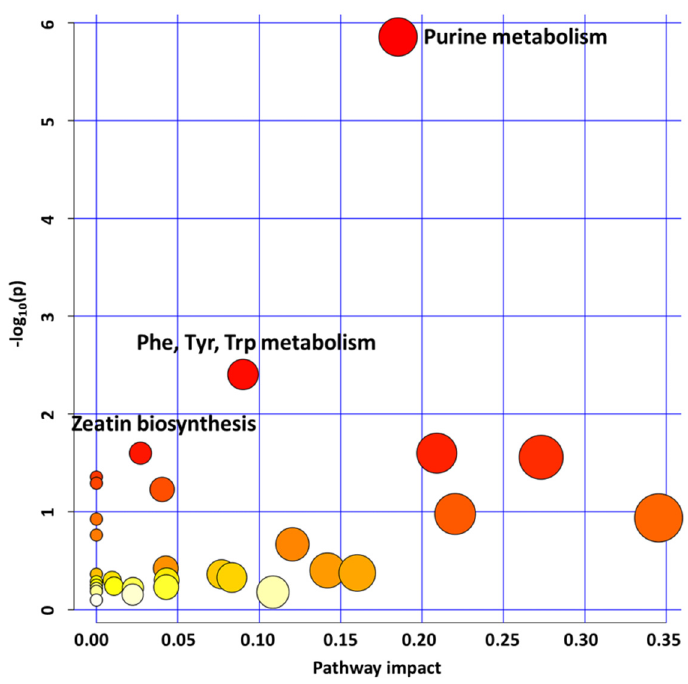
Figure 2. Metabolic pathway analysis plot. Color intensity (white to red) reflects increasing statistical significance, and circle diameter varies with the pathway impact. The graph was obtained by plotting on the y -axis the − log 10 transforms of p -values from the pathway enrichment analysis and on the x -axis the pathway impact values derived from the pathway topology analysis. The top three most significant pathways ( p -value < 0.05; pathway impact (pi) > 0) are depicted: purine metabolism ( p -value = 1.3987 × 10 − 6 , pi = 0.18529); phenylalanine, tyrosine, and tryptophan biosynthesis ( p -value = 0.0039386, pi = 0.09009); zeatin biosynthesis ( p -value = 0.025118; pi = 0.0271). The metabolomic analysis was repeated three times using different biological samples giving the same results.